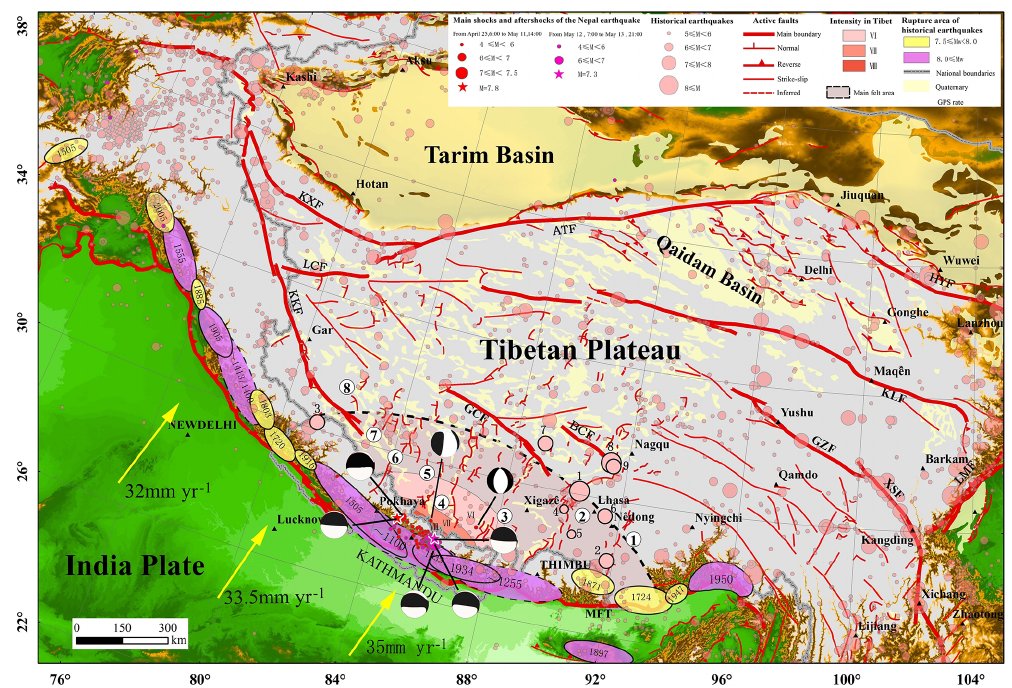
Figure 1. Principal active faults and historic earthquakes in the Himalaya Mountains, Tibetan Plateau, and neighboring areas. The earth- quake data are from the Science and Technology Committee and the archives in Xizang Autonomous Region (1982), Bilham (2004), and Avouac (2007). GPS data are from Bettinelli et al. (2006). The focal mechanism solution data are from USGS (2015a, b), the Institute of Geophysics„ China Earthq. Admin. (2015), and the China Earthquake Administration (2015). Circled numbers denote rifts in southern Tibet as follows: (1) Cona–Oiga rift, (2) Yadong–Gulu rift, (3) Dinggye–Xainza rift, (4) Gangga–Tangra Yumco rift, (5) Nyalam–Coqên rift, (6) Zhongba–Gêrzê rift, (7) Kunggyu Co–Yagra rift, and (8) Burang–Gêgyai rift. Thrust and strike-slip faults are denoted as follows: MFT, Main Frontal Thrust fault of Himalaya; KKF, Karakorum fault; GCF, Gyaring Co fault; BCF, Beng Co fault; GZF, Ganzi fault; XSF, Xianshuihe fault; KLF, Kunlunshan fault; LMF, Longmenshan fault; LCF, Longmu Co fault; KXF, Kangxiwa fault; AFT, Altyn Tagh fault; and HYF, Haiyuan fault. Numbers 1–9 denote the M ≥ 6 . 8 historic earthquake epicentral areas in southern Tibet: 1 – 1411 M 8.0